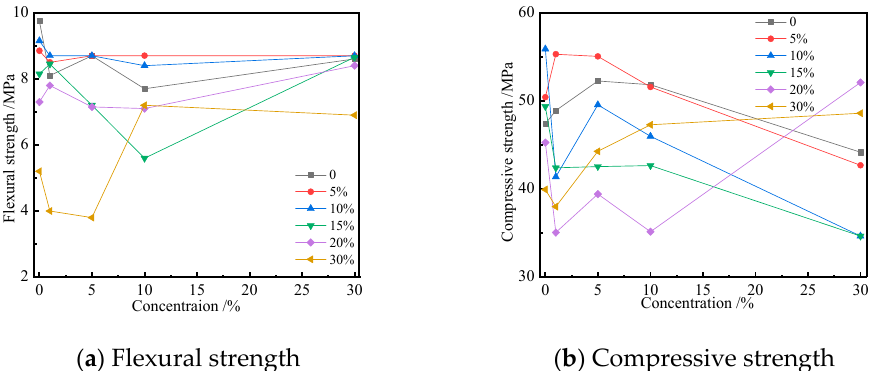
Figure 2. Strength variation of the mortar containing fly ash with sulfate solution concentrations.